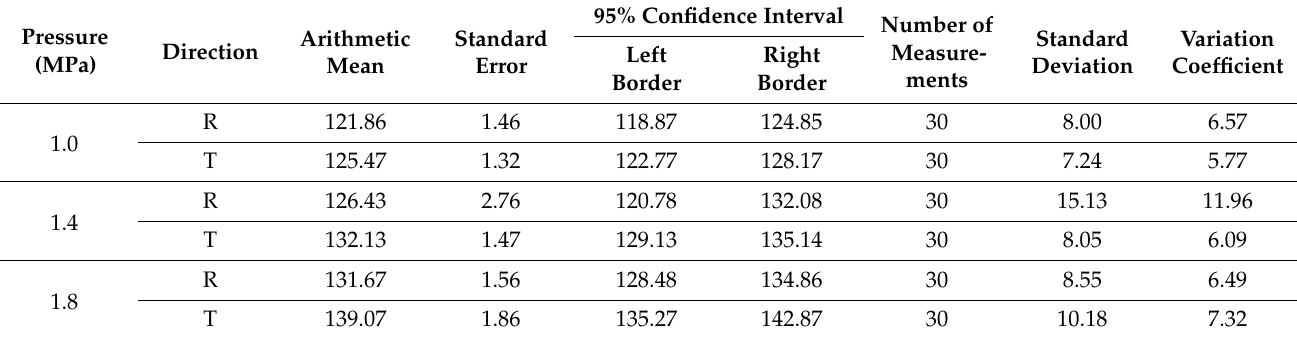
Table 3. Statistical characteristics during contact drying—bending strength.